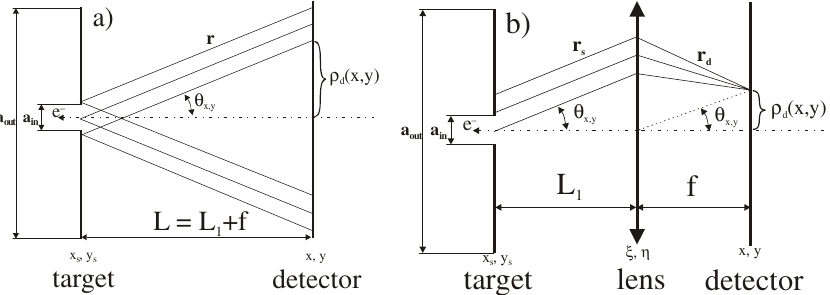
FIG. 1. Geometry of the DR production: (a) without the lens; (b) with the lens. Here x surface; (cid:4) and (cid:5) are the coordinates of the lens surface; x and y are the detector coordinates; L lens; f is the lens focus, L (cid:5) L from the specular reflection direction, a use the slit and screen dimensions in the perpendicular direction along the x -axis named as b